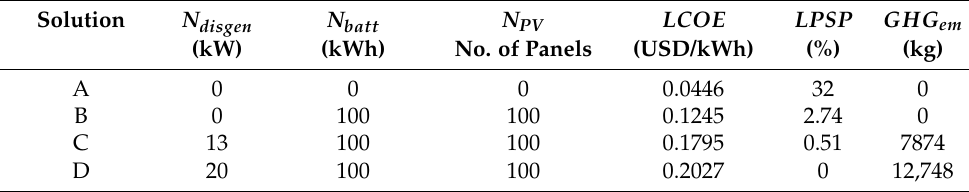
Table 7. Optimization solutions of